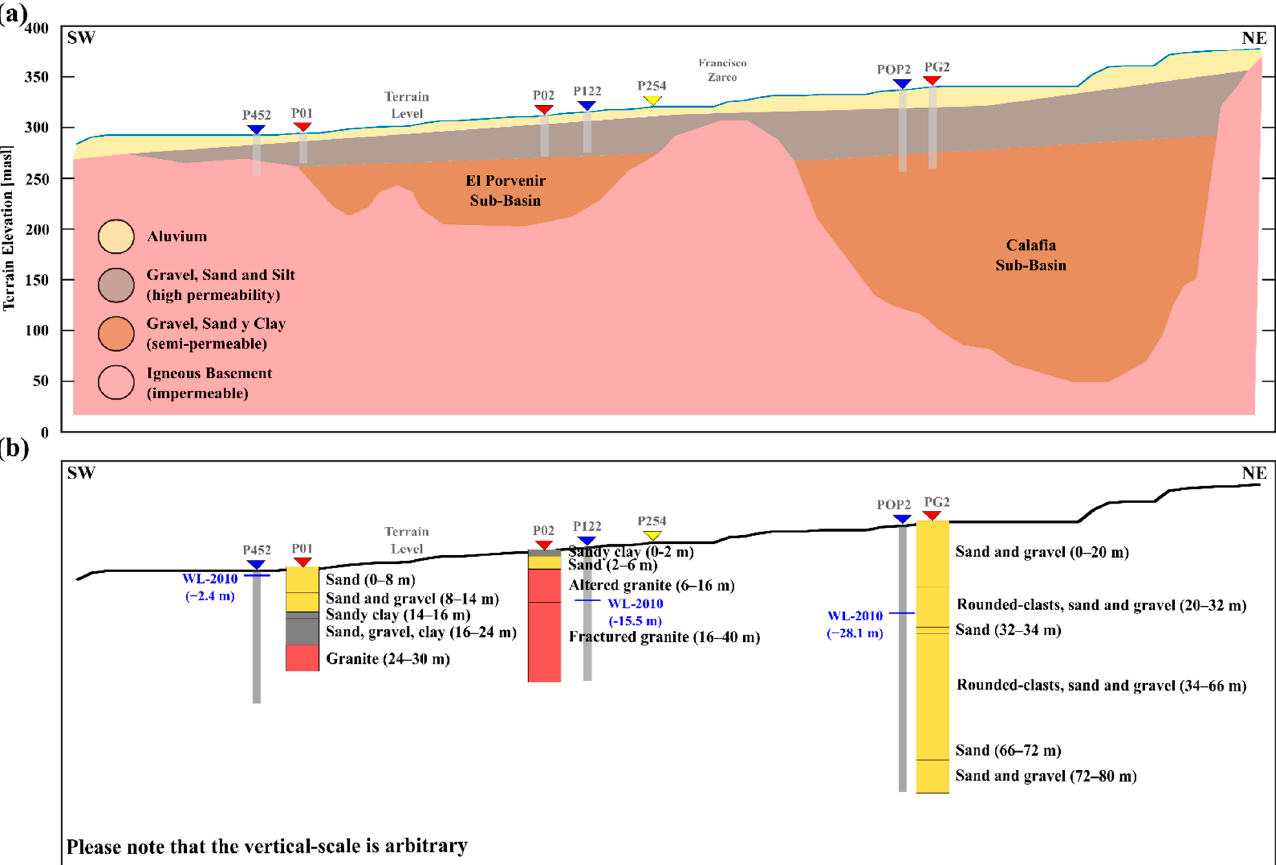
Figure 2. ( a ) Schematic hydrogeological conceptualization of the Guadalupe Valley Aquifer, after Reference [5]. The approximate location of the monitoring wells included as a part of this study is shown. ( b ) Simplified stratigraphic columns of the rock units drilled by the reference wells (P01, P02, and PG2) [2]. The water level measured in 2010 is